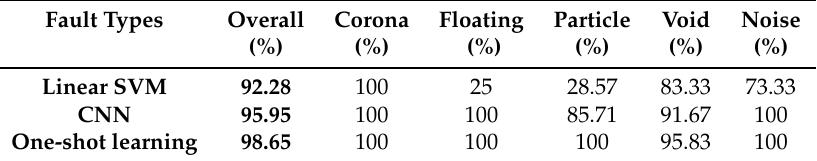
Table 3. Performance comparisons in terms of